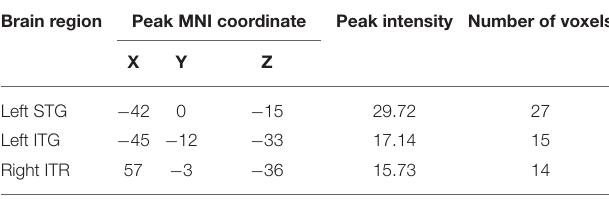
TABLE 2 | Details of three brain regions where HL and cognition